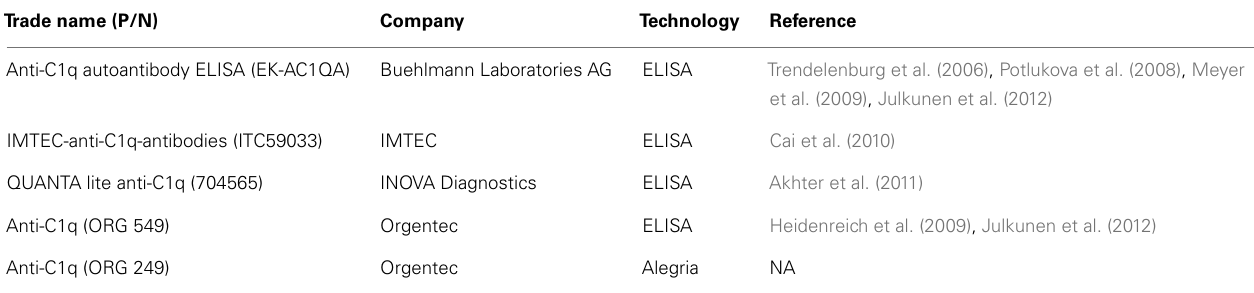
Table 2 | Overview of commercially available assays for the detection of anti-C1q